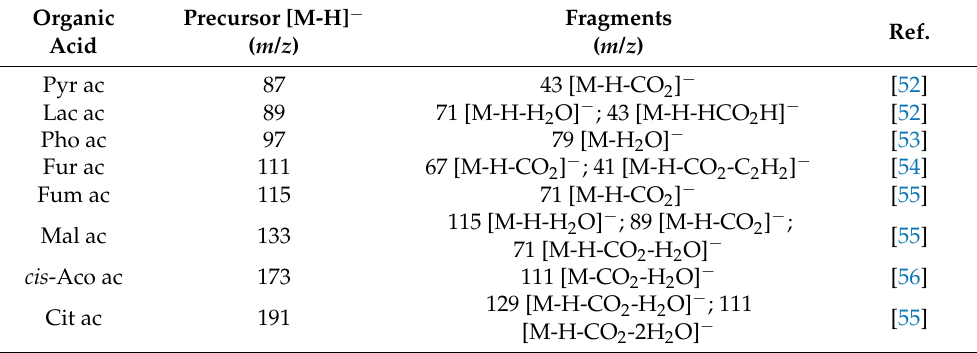
Table 3. Fragmentation data obtained by negative ESI-MS/MS infusion experiments in daughter scans for the precursor ions assigned to pyruvic (Pyr ac), lactic (Lac ac), phosphoric (Pho ac), 2-furoic (Fur ac), fumaric (Fum ac), malic (Mal ac), cis -aconitic ( cis -Aco ac) and citric (Cit ac) acids.